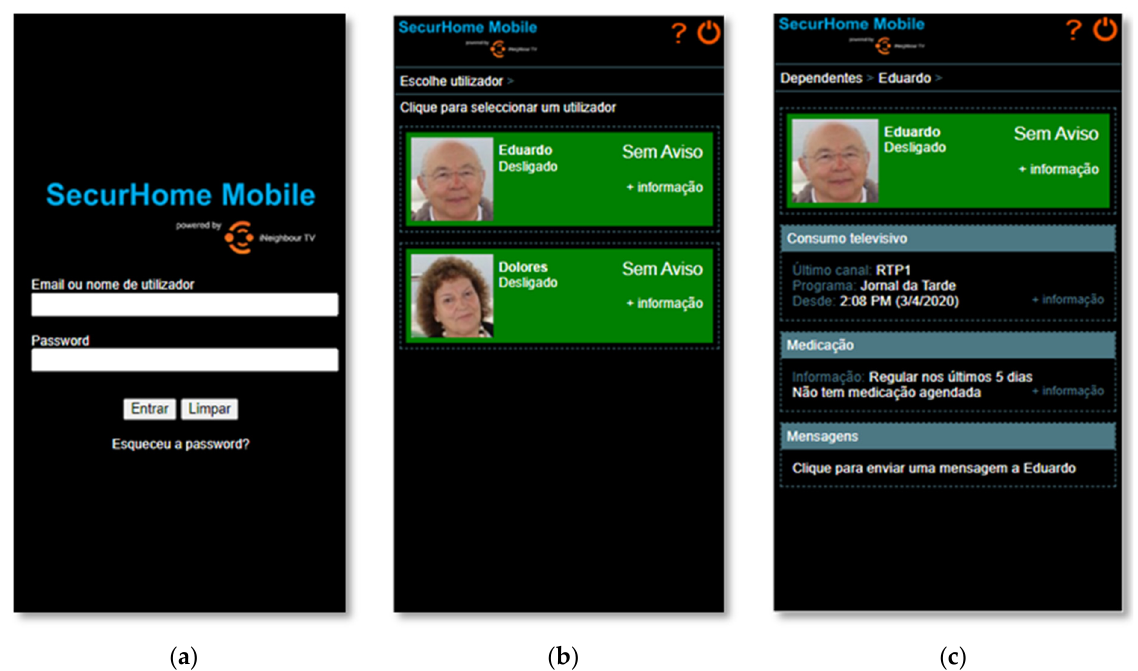
Figure 12. ( a ) Home screen of SecurHome Mobile; ( b ) the Dependents area of SecurHome Mobile; ( c ) the Dependent Details area of SecurHome Mobile.